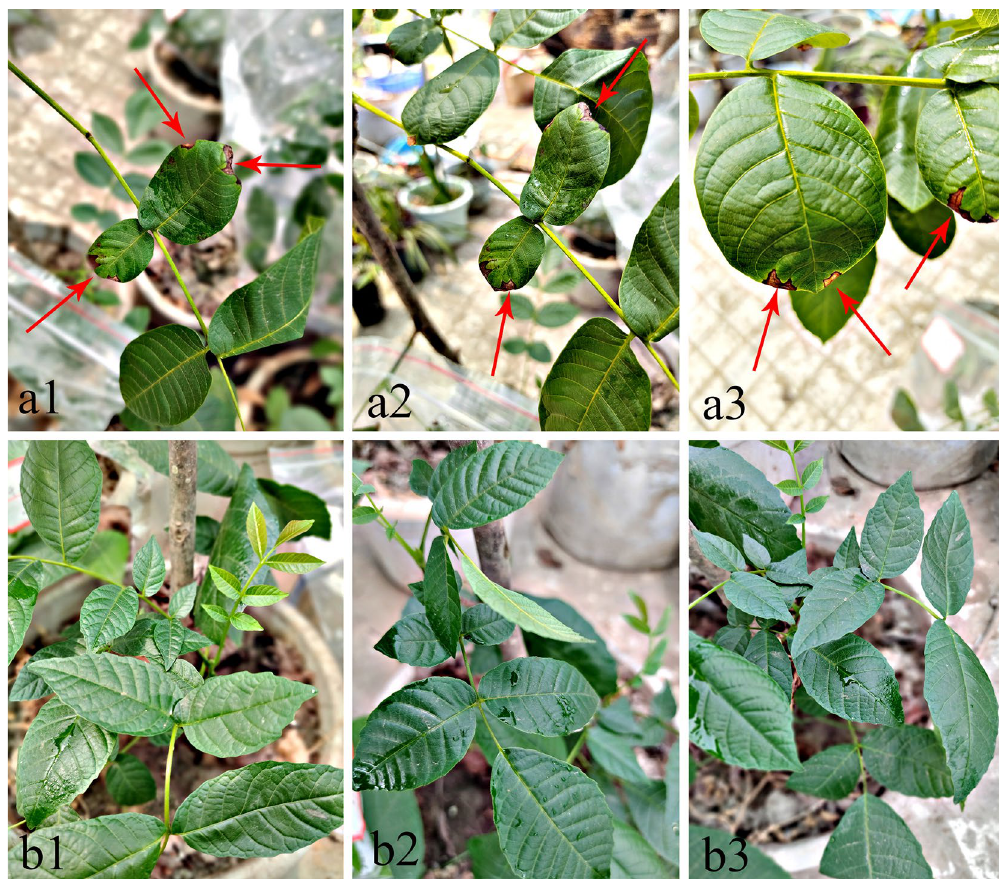
Figure 4. Symptoms on tender leaves in vitro experiments after 15 days inoculated with spore suspension. ( a1 – a3 ) Symptoms of inoculation with spore suspension; ( b1 – b3 ) Symptoms of inoculation with sterile